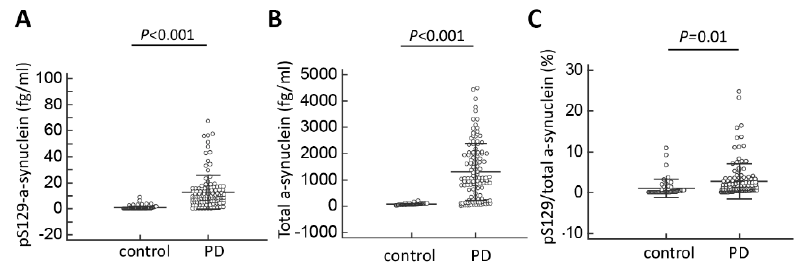
Figure 1. Plasma total and phosphorylated Ser129- α -synuclein levels for all participants in the study. ( A ) The plasma levels of pS129- α -synuclein, ( B ) total α -synuclein level and ( C ) the pS129 / total α -synuclein ratio were significantly increased in patients with Parkinson’s disease (PD) compared to normal controls.